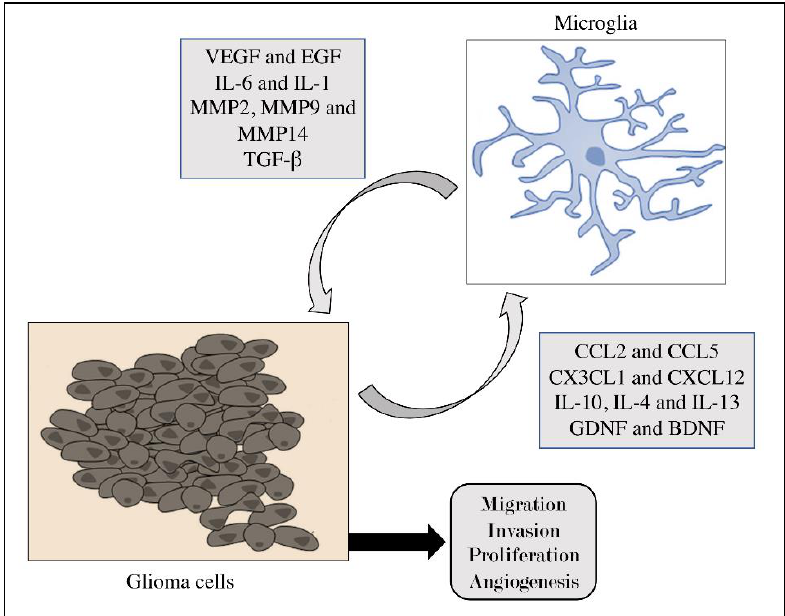
Figure 2. Cross-talk between glioma cells and microglia.